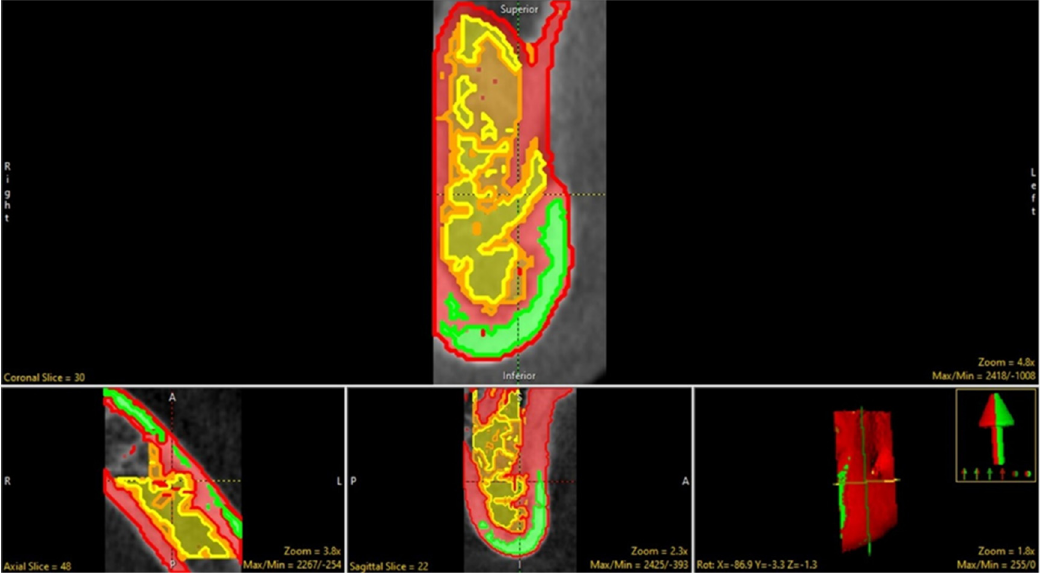
Figure 5. The measurement of desired trabecular parameters via BMA (green, yellow, and red denote inter − trabecular space, cortical bone and trabecular septa, respectively; A: Anterior; P: Posterior; L: Left; R: Right).